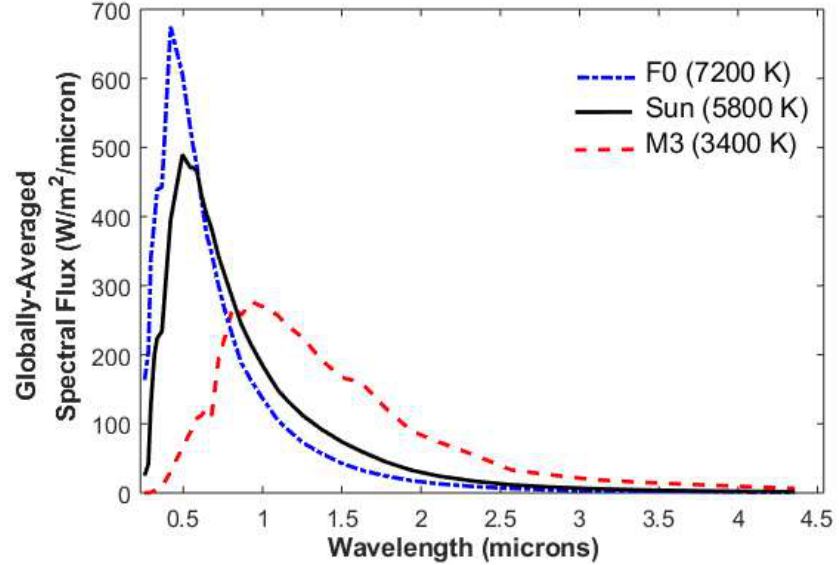
Figure 6. Globally-averaged incoming stellar spectra for the Sun, F0, and M3 stars. Adapted from Ramirez and Kaltenegger [2] and updated from Ramirez [22].